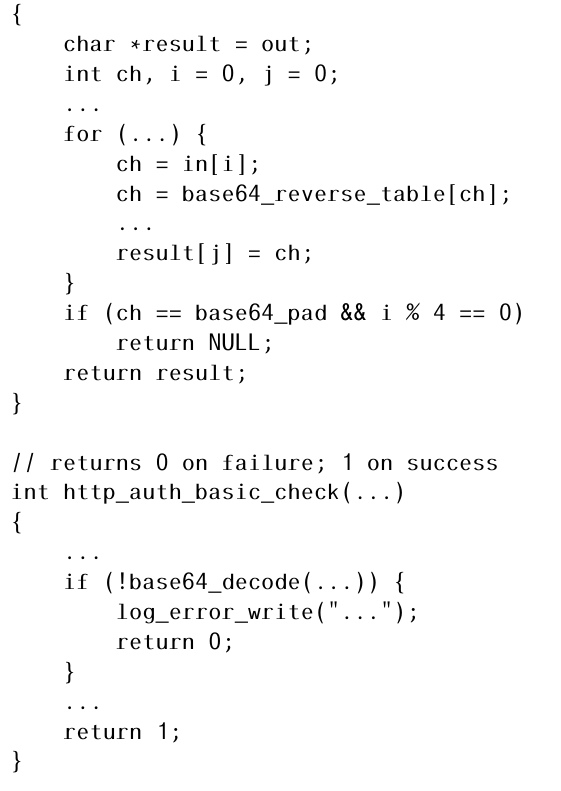
Figure 2. An SWRR instrumented into the vulnerable base64_decode function listed in Figure